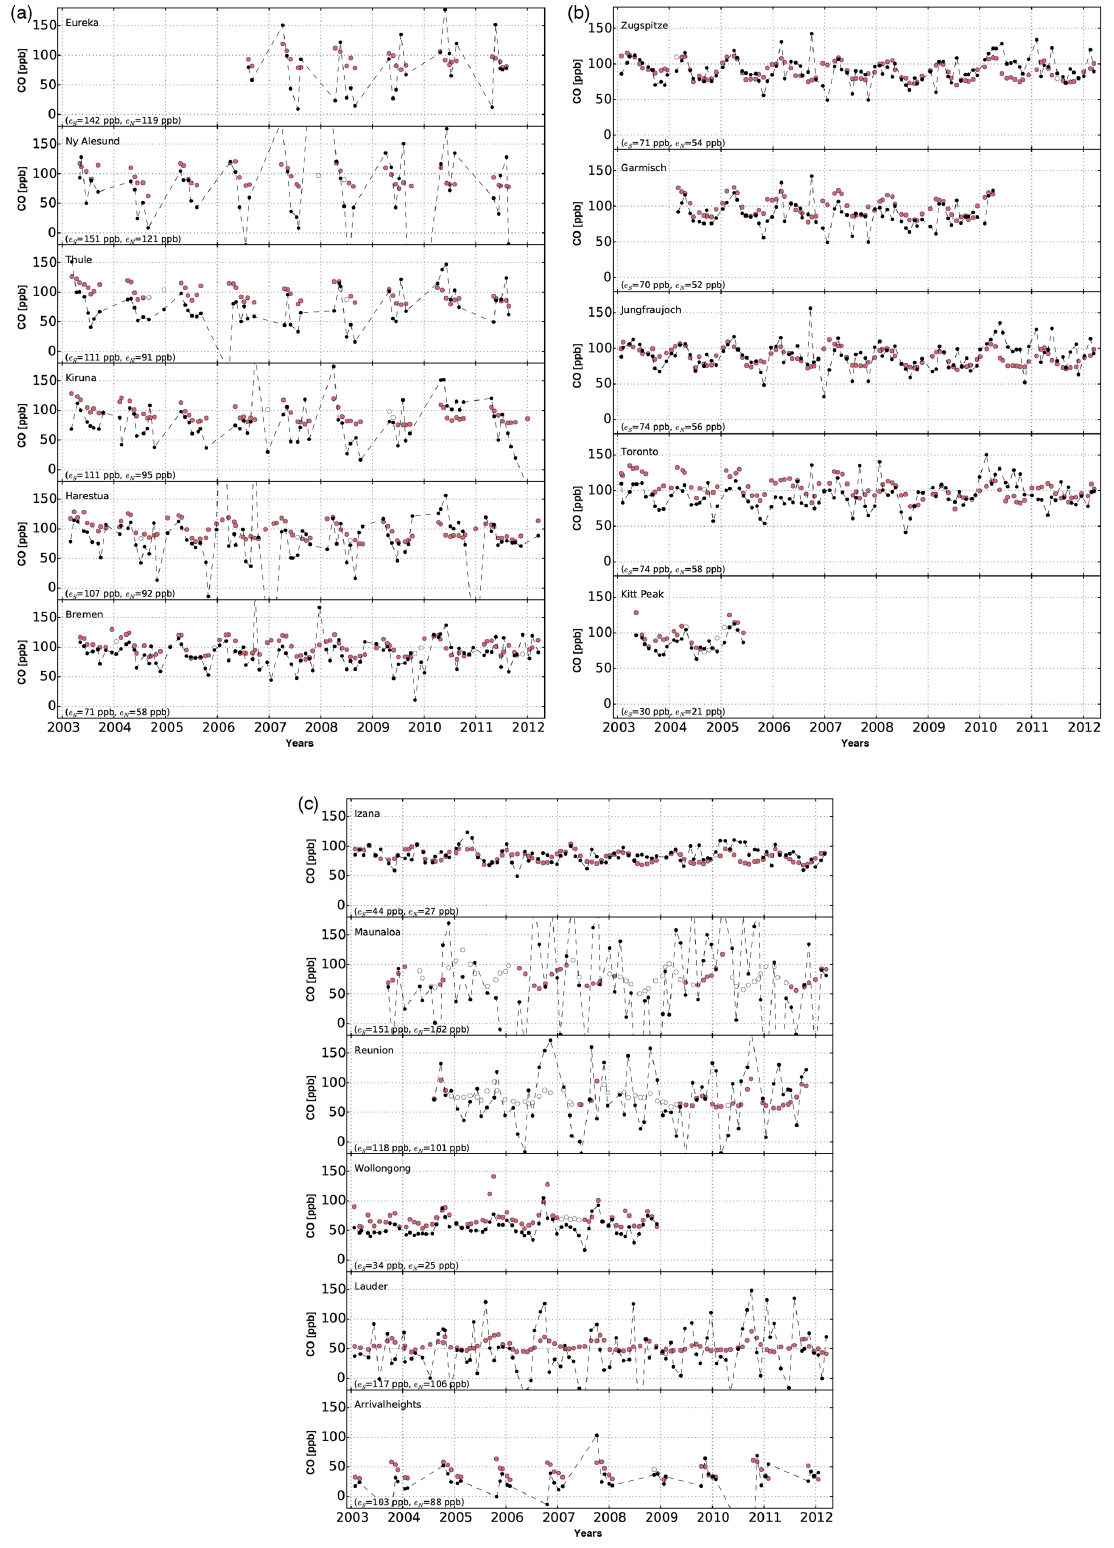
Figure 6. The 30-day medians of CO wet air column averaged mixing ratios measured by SCIAMACHY (black) and at various NDACC- IRWG stations (pink). To derive mixing ratios from the CO columns supplied by NDACC-IRWG we calculated total air columns from the surface pressure per station. Open circles denote interpolated values for periods where no NDACC-IRWG measurements are